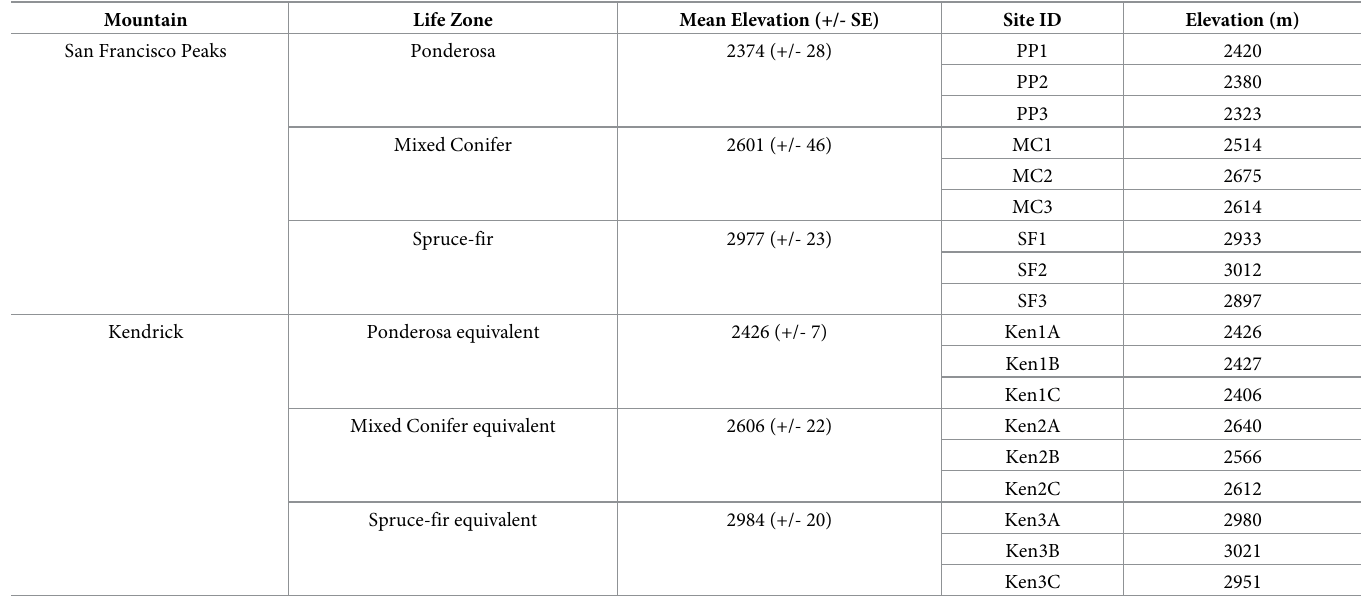
Table 1. Locations and elevation of each of the nine sites per mountain (The San Francisco Peaks and Kendrick). Mountain Life